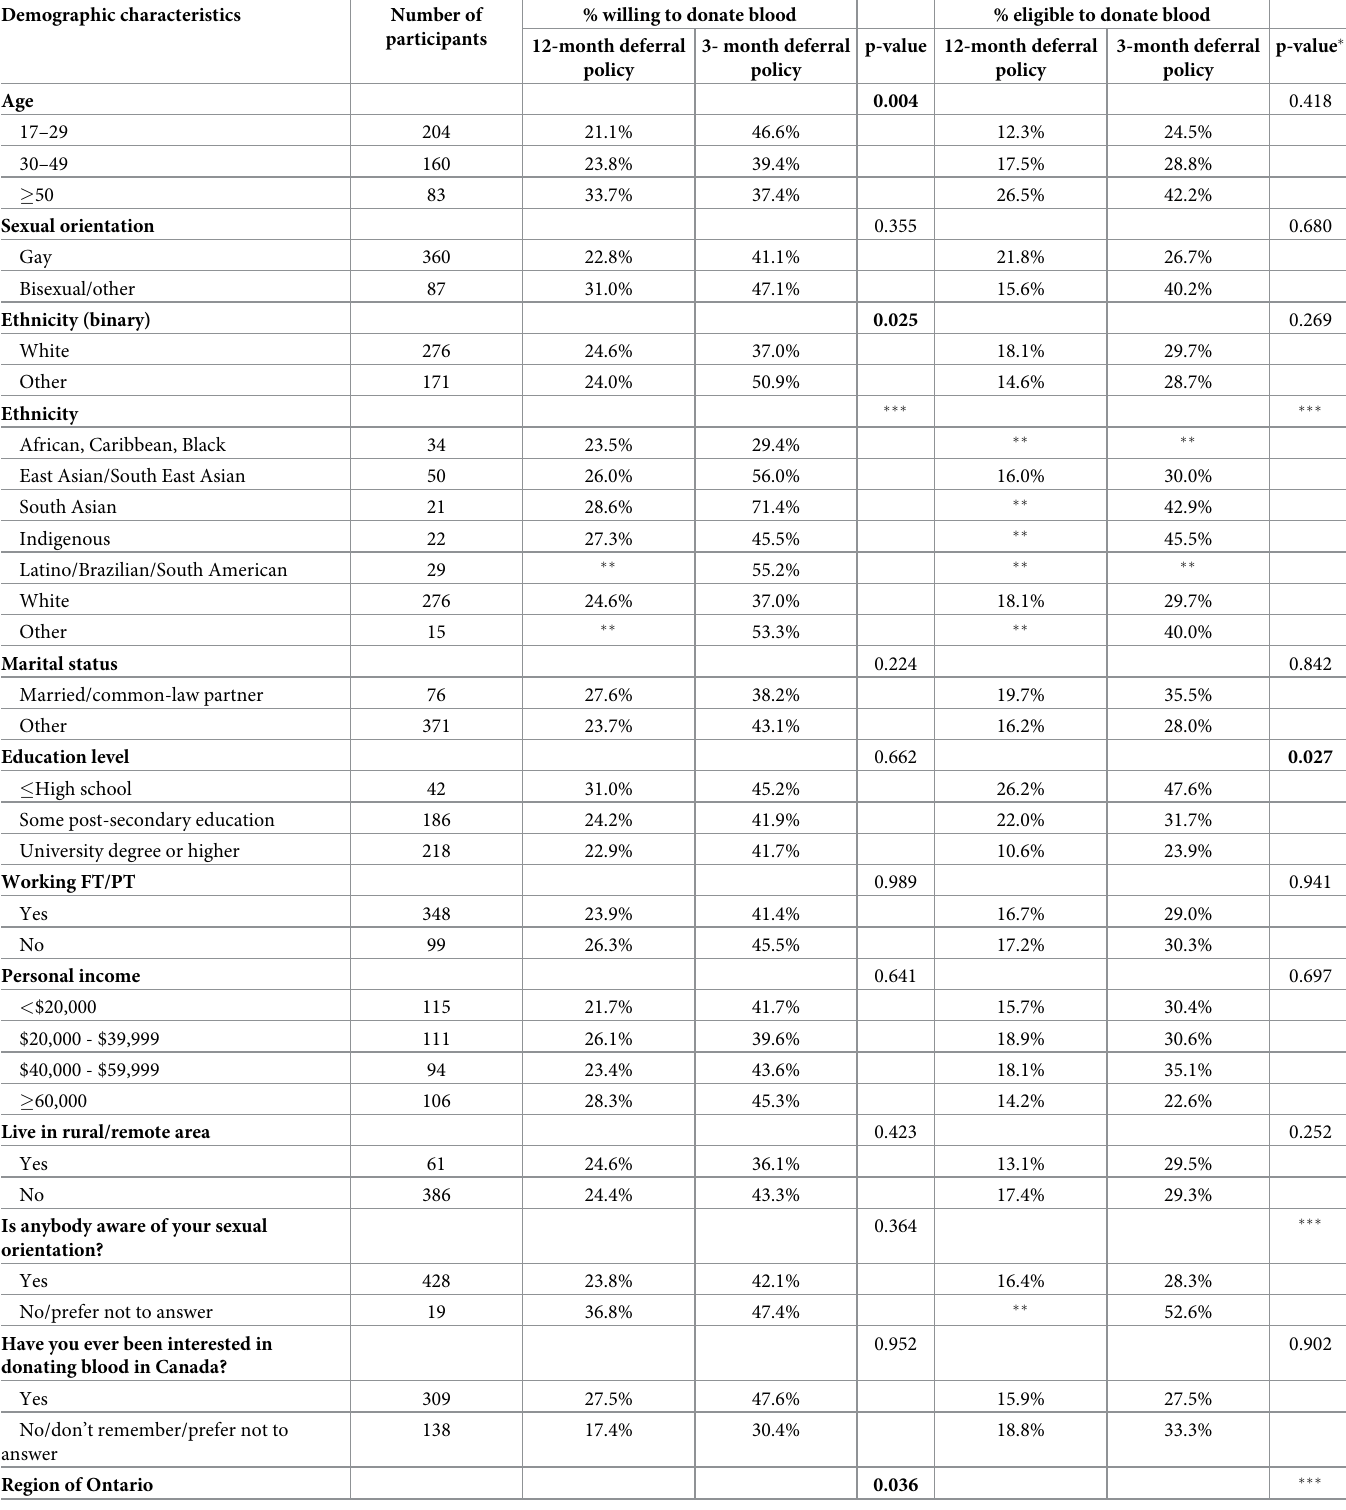
Table 2. Willingness and eligibility to donate blood among study participants under 12-month and 3-month deferral policies. Demographic